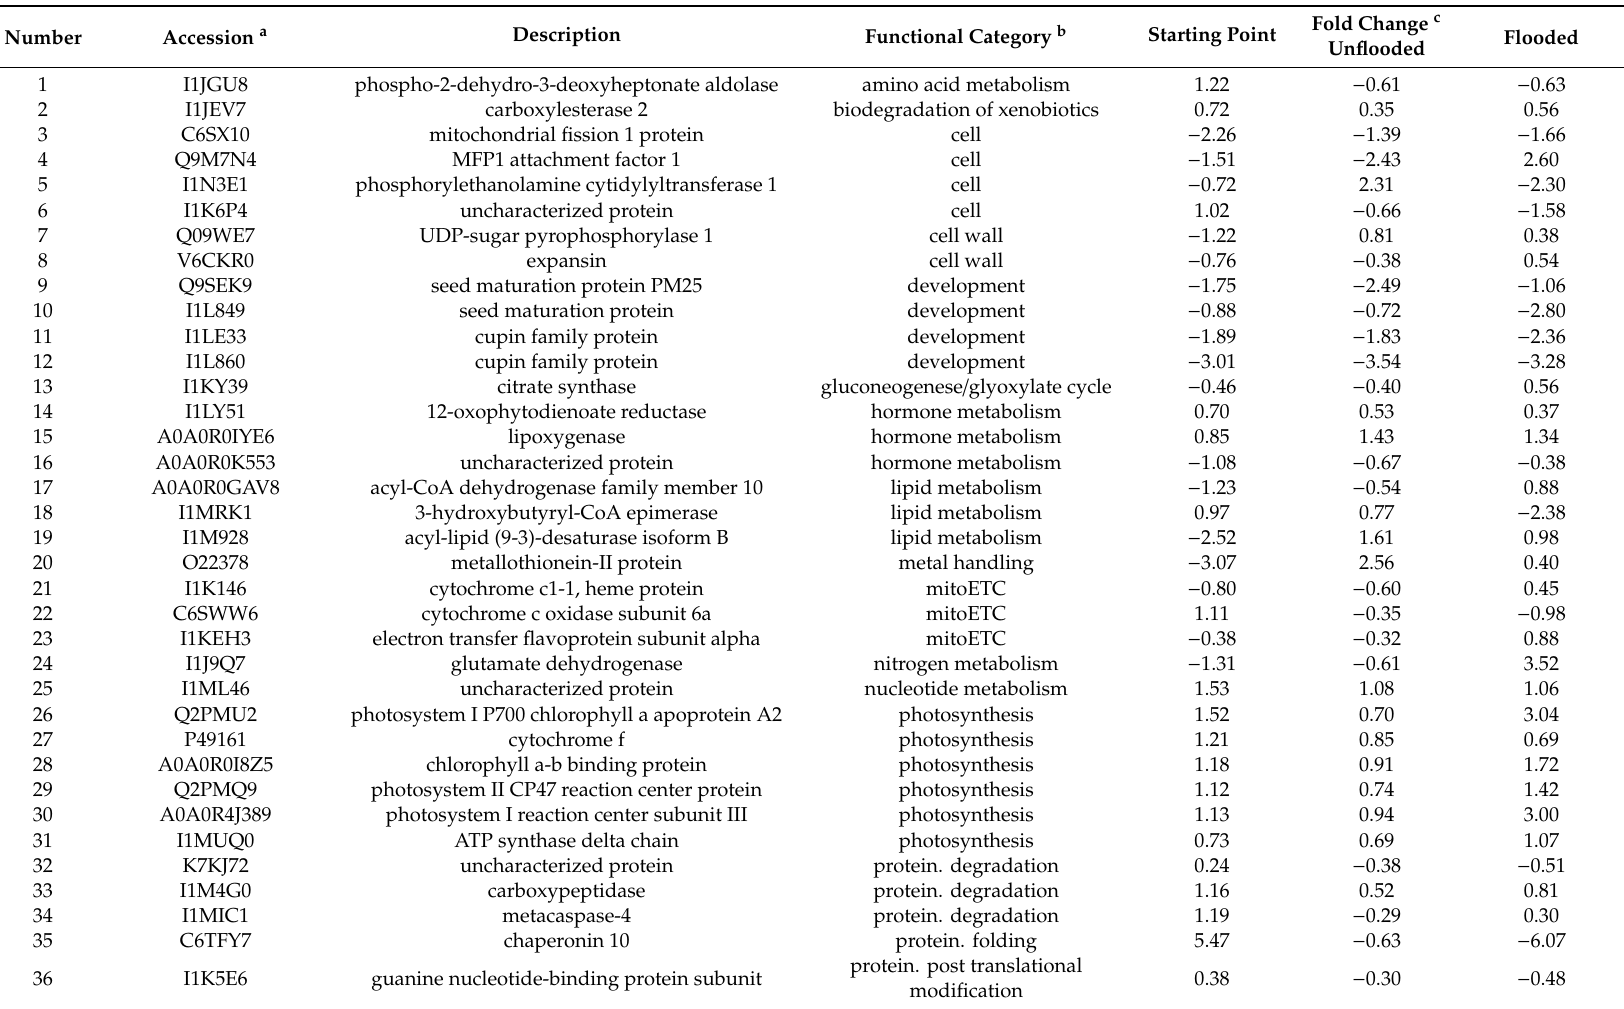
Table 1. List of proteins altered at all three stages (2-day old, 4-day old without flooding, 4-day old with flooding) of soybean irradiated with millimeter